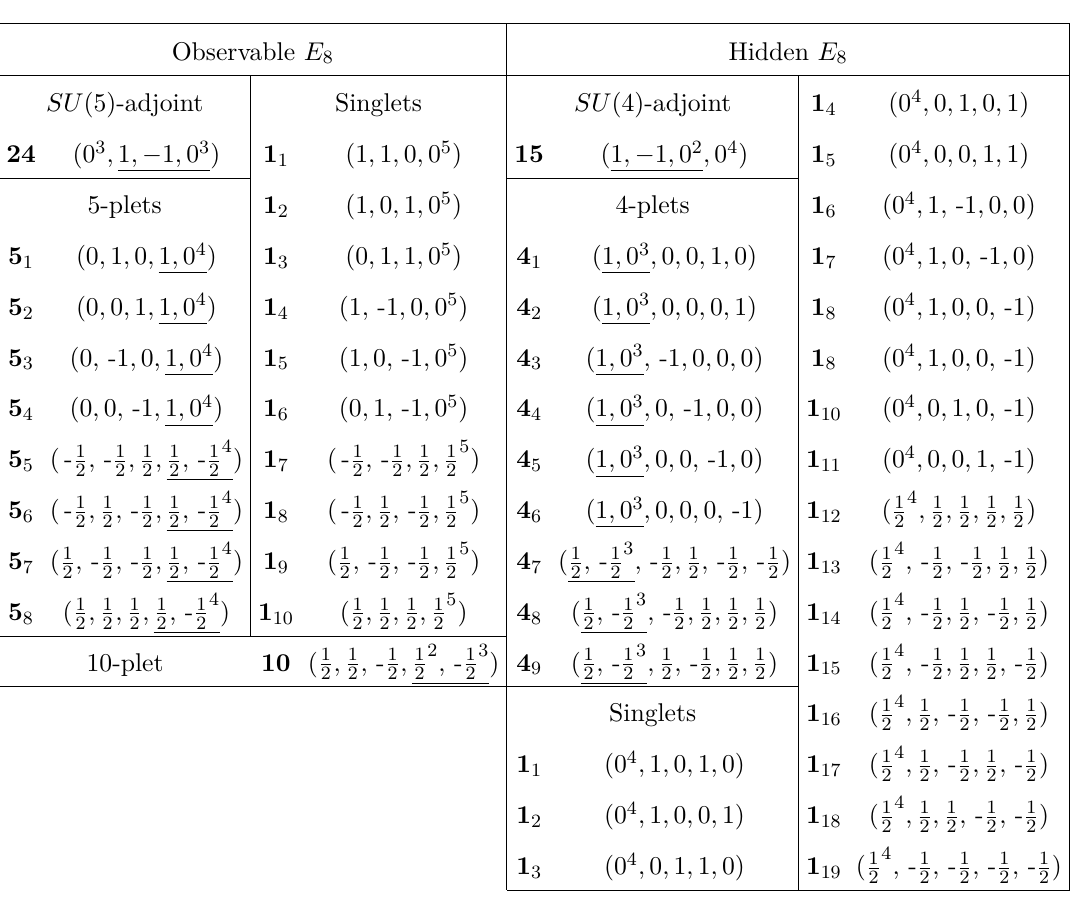
Table 9 . The identification between the roots and the states in the spectrum in both the observable and hidden sectors. States in the same non-Abelian representation but with different U(1) -charges are